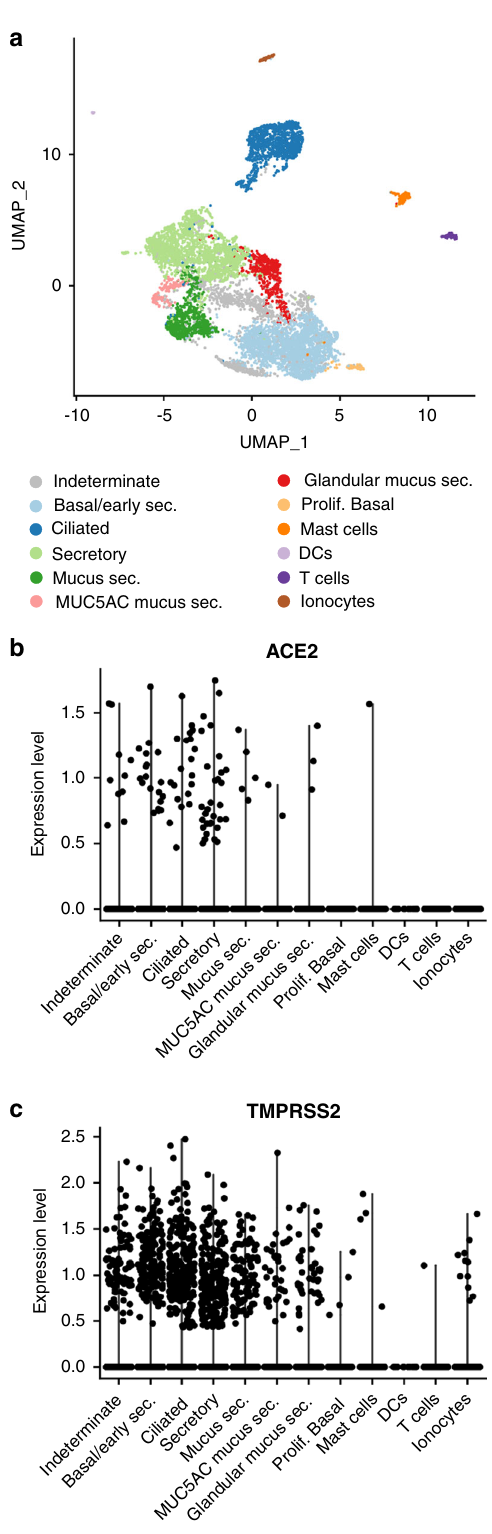
Fig. 1 ACE2 and TMPRSS2 are expressed by multiple nasal airway cell types. a UMAP visualization of 8,291 cells derived from a human nasal airway epithelial brushing depicts multiple epithelial and immune cell types identi fi ed through unsupervised clustering. b Log Count Per Million (CPM) normalized expression of ACE2 in epithelial and immune cell types. c Log CPM normalized expression of TMPRSS2 in epithelial and immune cell